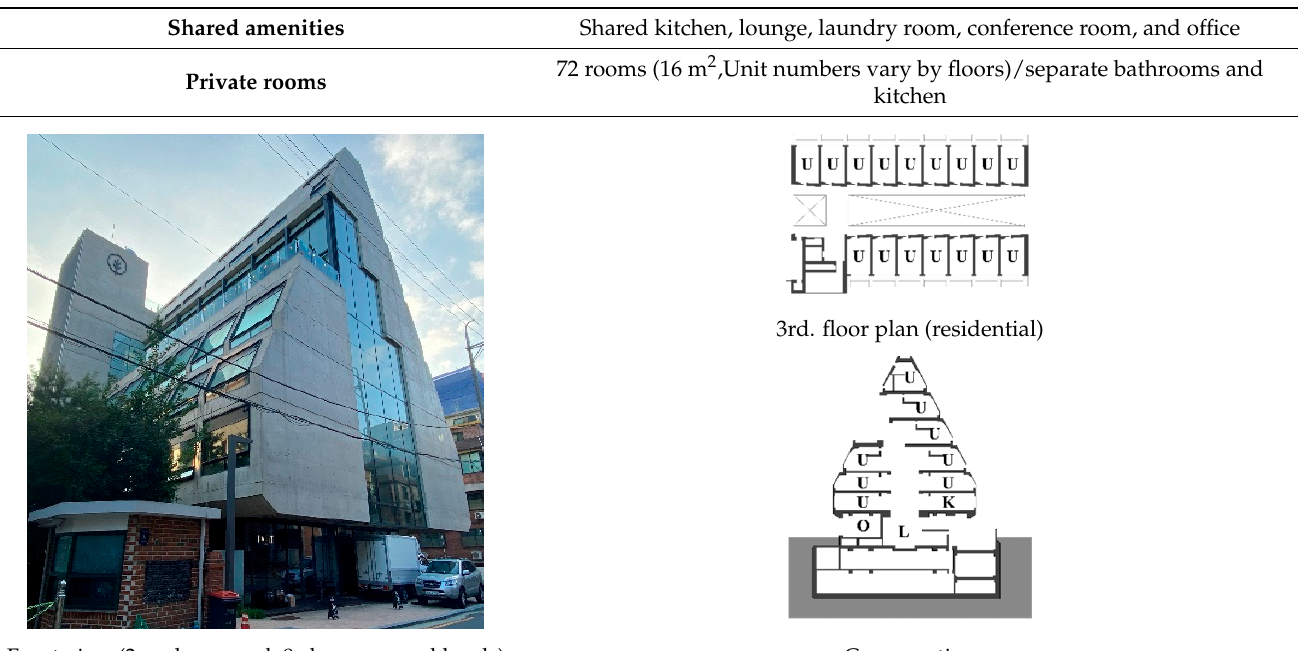
Table 7. Tree house [26].